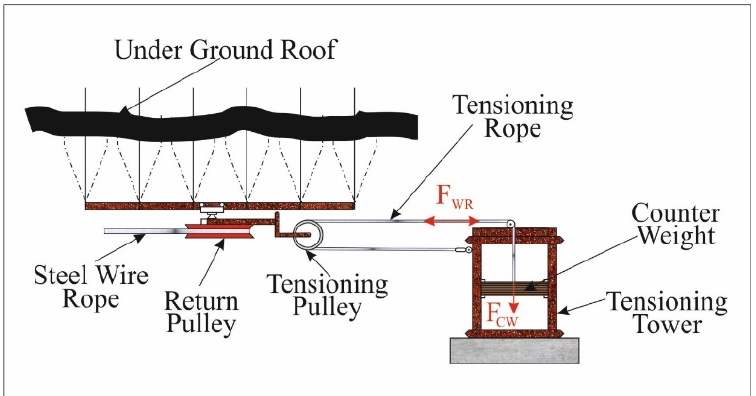
Figure 8. Rope Tensioning Unit.